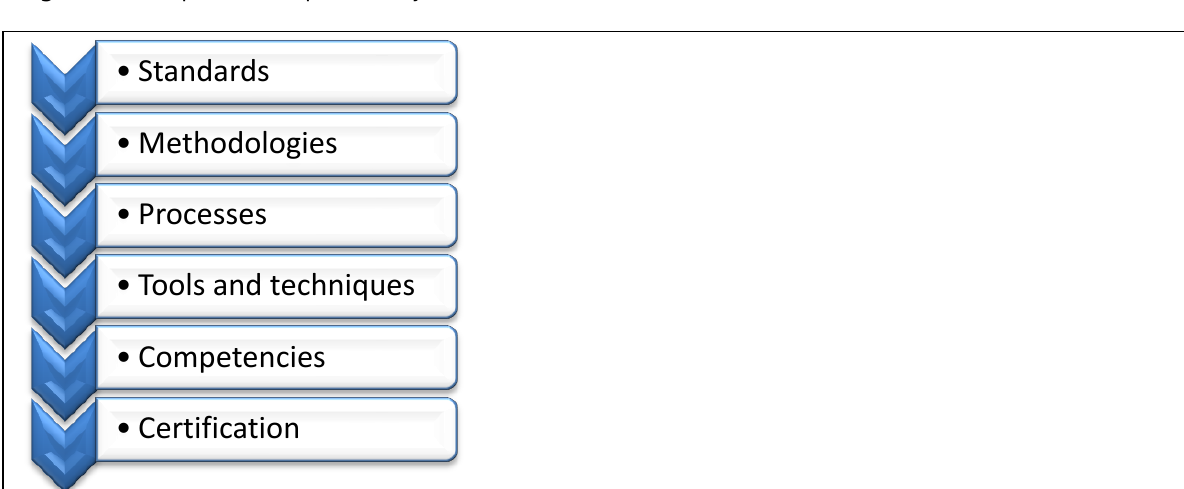
Figure 2. Components of